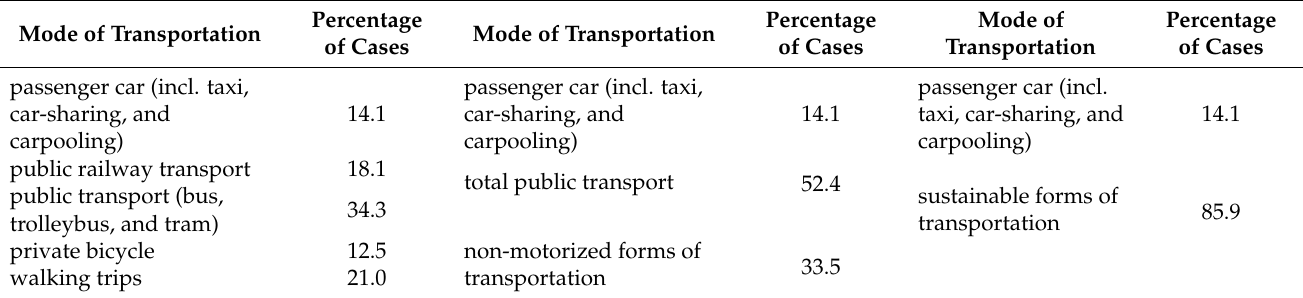
Table 2. What does the metropolitan bike replace for you most often? ( n = 500).